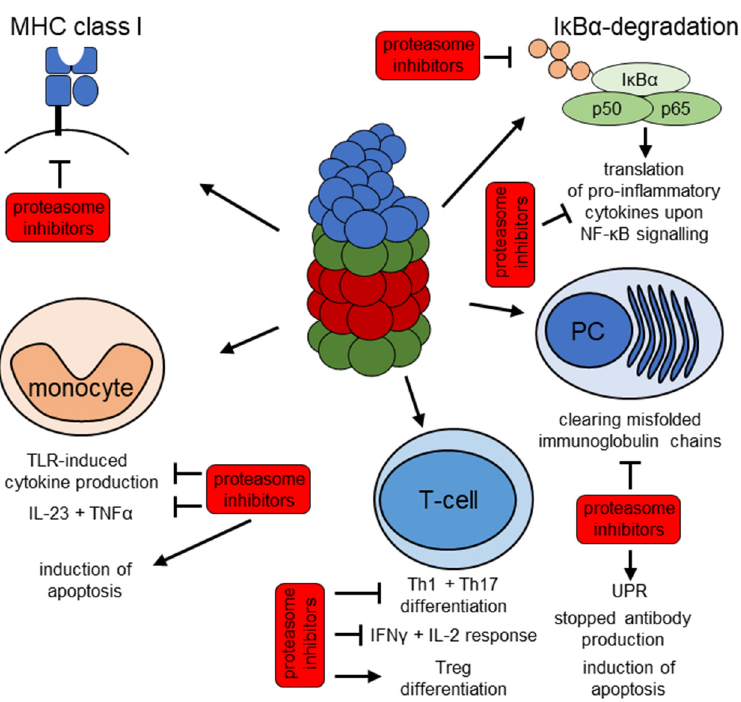
Figure 3. Overview of the potential anti-inflammatory mechanisms of proteasome inhibitors. Proteasome inhibitors including bortezomib, carfilzomib, ONX 0914 and KZR 616 were shown to exert anti-inflammatory effects via different mechanisms. These involve all cells: an influence on MHC class I antigen presentation ( top left ) and degradation of I κ B α ( top right ), which results in NF- κ B nuclear translocation and transcription of pro-inflammatory cytokines. Specific effects on cellular subsets include a targeted anti-inflammatory and proapoptotic effect on monocytes which results in a reduction in pro-inflammatory cytokine production upon TLR stimuli ( bottom left ). In T-cells, active IP are required for differentiation into Th1 and Th17 phenotypes ( bottom center ), whilst IP inhibition results in increased Treg differentiation and decreased IFN- γ production, as indicated. Plasma cells (PC) are especially sensitive to reduced proteasomal activity, which results in apoptosis most likely via activation of the UPR and in depletion of autoantibodies ( bottom right